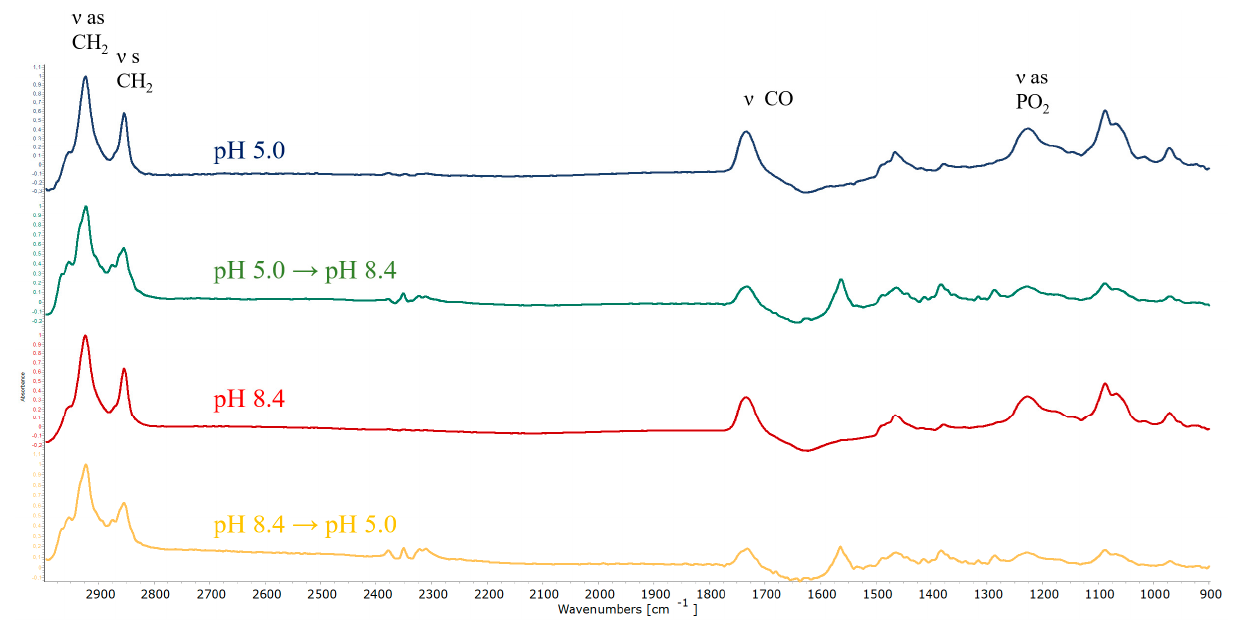
Figure 6. Normalized ATR-FTIR spectra of POPC/AMS liposomes in various media. Total lipid concentration 5 mg/mL, α AMS = 0.1, 22 ◦ C.